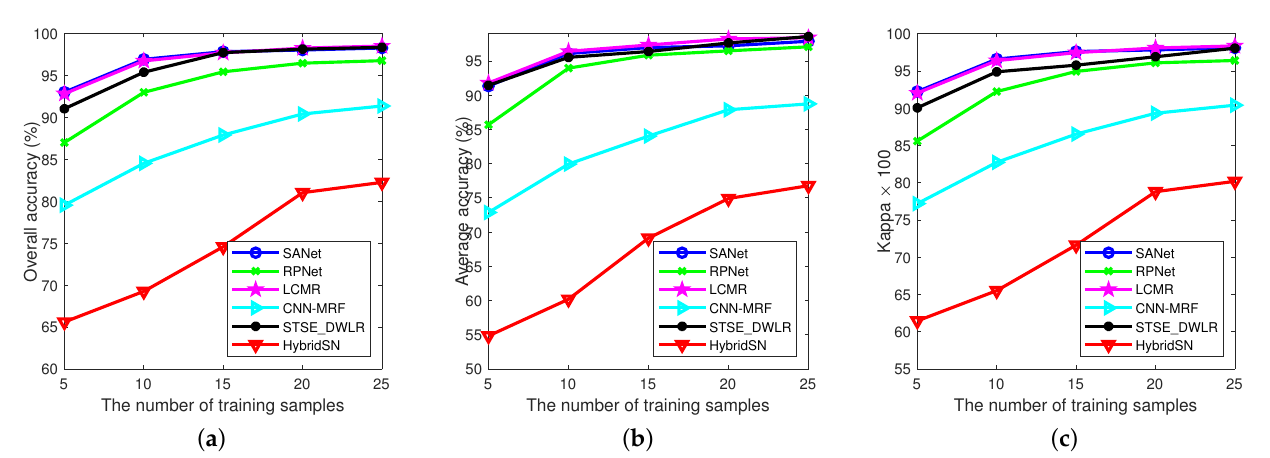
Figure 17. Experimental results of different methods with various numbers of training samples on KSC data set. ( a ) OAs; ( b ) AAs; ( c ) κ